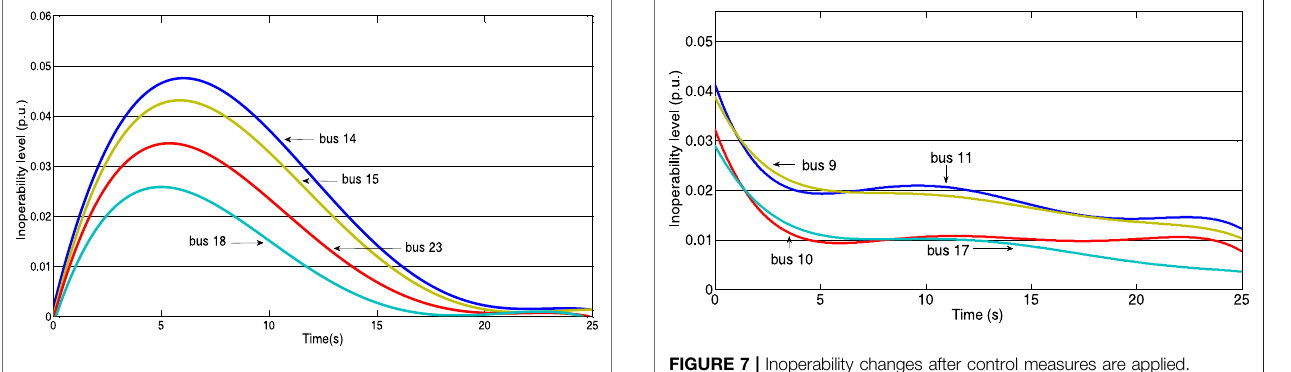
FIGURE 5 | Change of node inoperability under small disturbances.